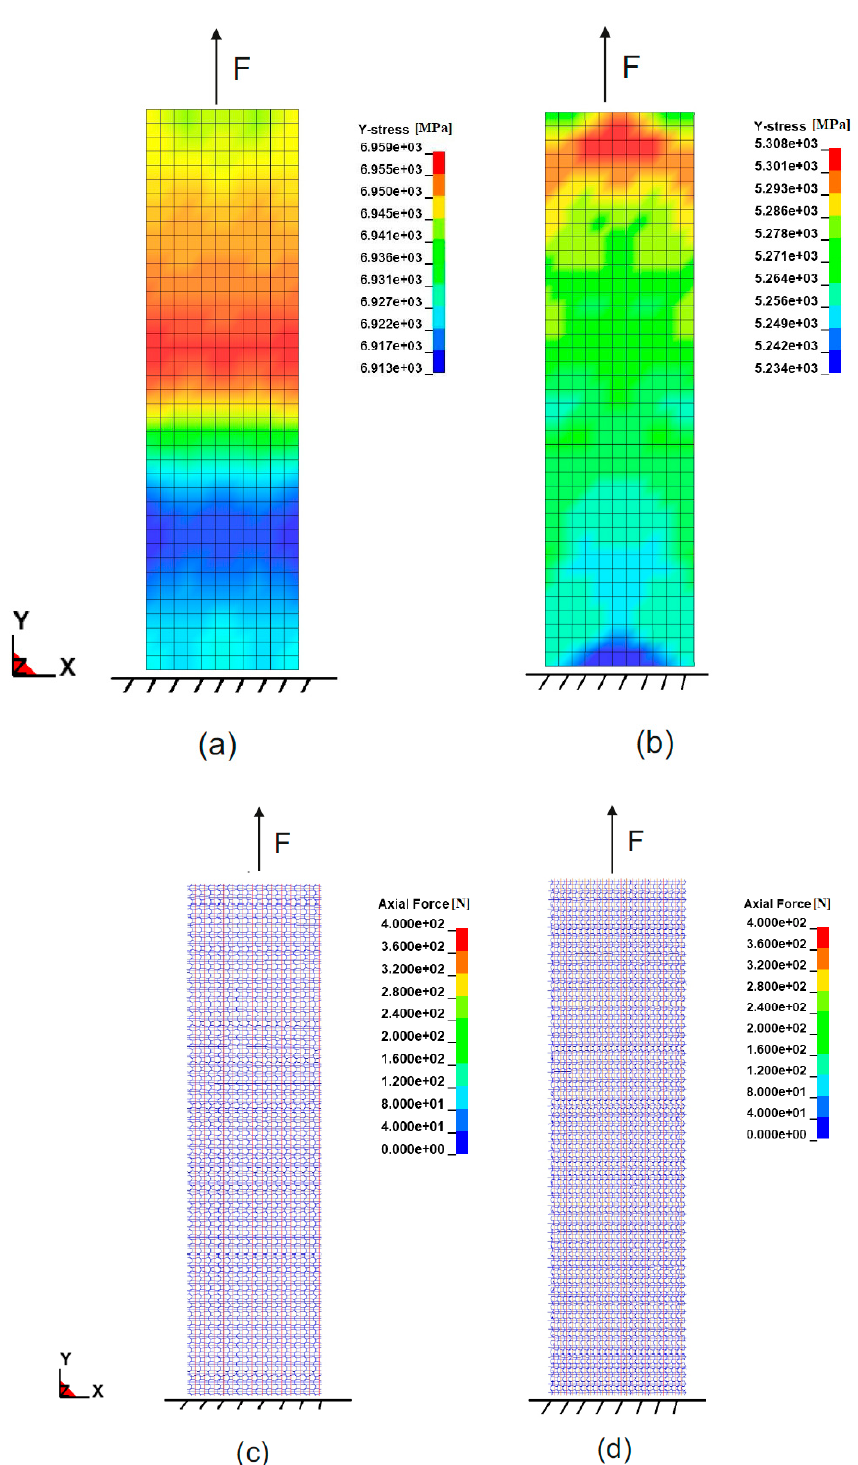
Figure 9. Tensile test simulation of textile fabric stripe in the weft direction with macro-scale model of ( a ) variant 1, ( b ) variant 2 (stress of textile in the weft direction presented) and with meso-scale model of ( c ) variant 1, ( d ) variant 2 (axial force of yarn presented).